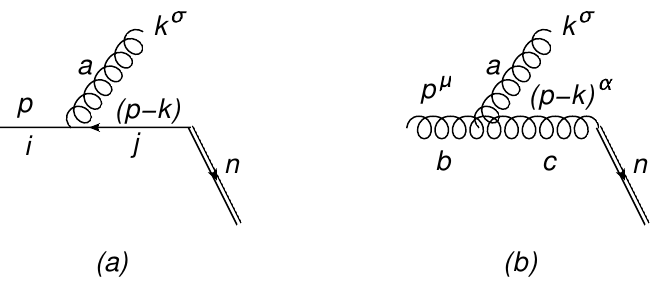
Figure 1 . Tree-level contribution to the radiative jet function for (a) an external quark; (b) an external